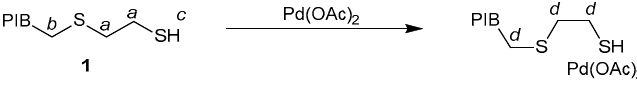
Scheme 3. Tentative Pd chelation.